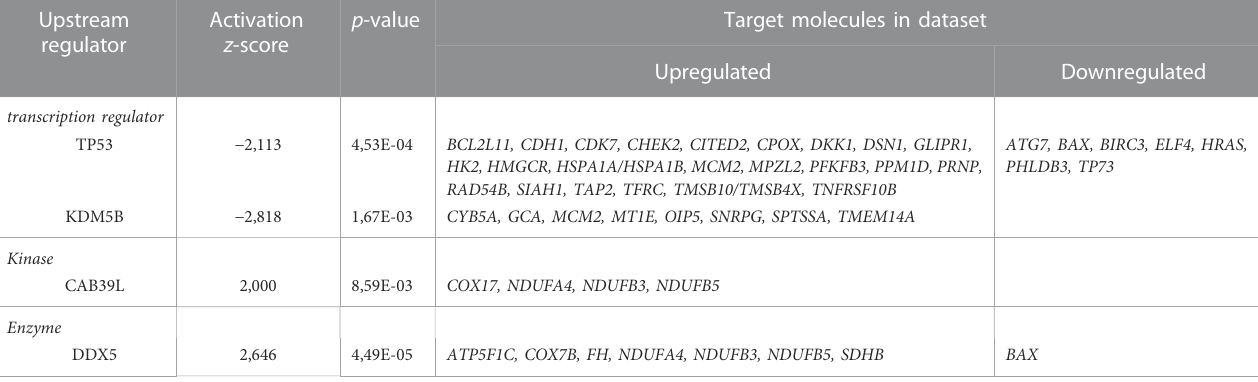
TABLE 2 Potential upstream regulators of palmitate and HK4-induced gene expression pro fi le. Upstream